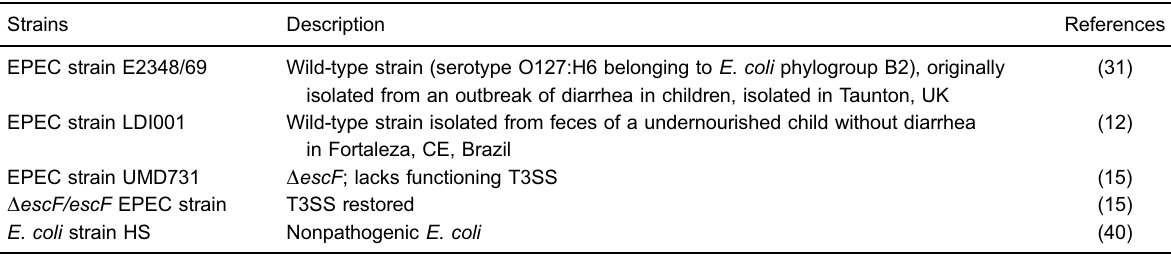
Table 1. Bacterial strains used in this